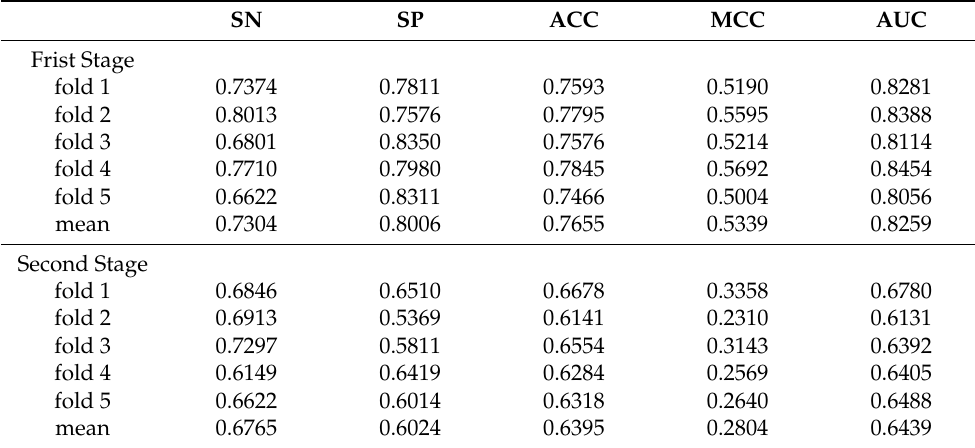
Figure 4. The ROC curves of 5-fold cross validation ( A ) for recognizing the enhancers and ( B ) for distinguishing strong from weak enhancers. The purple line is the baseline of ROC curve, named random guessing line. Table 2. Performances of 5-fold cross